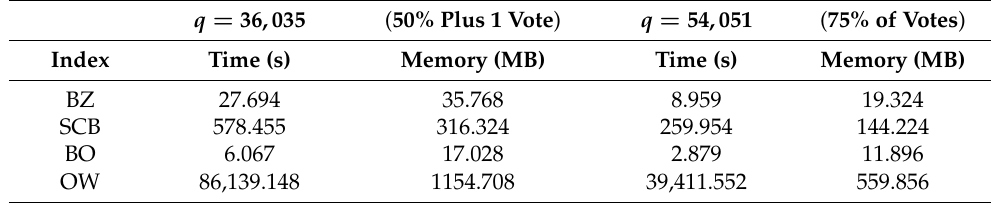
Table 3. Computing times and memory requirements for an example with 3434 players, ˜ w = 72,068, 200 precoalitions, a maximum coalition size of 54 and an average coalition size of